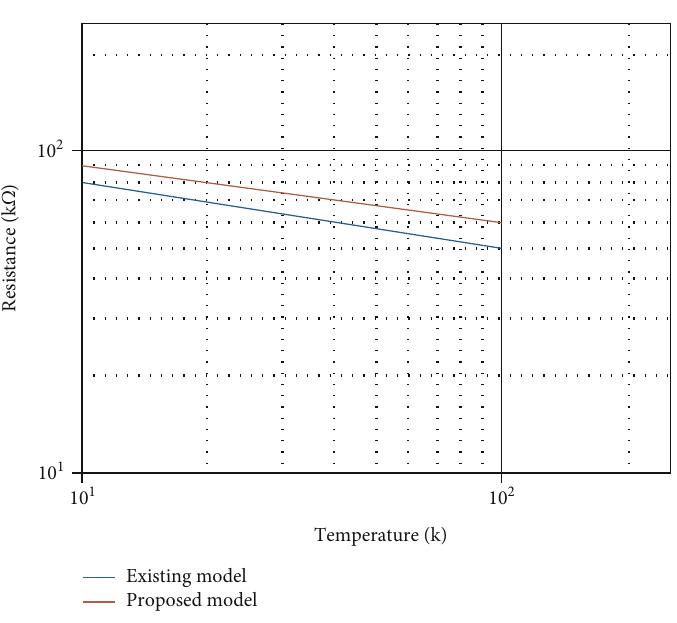
Figure 9: Temperature vs. resistance